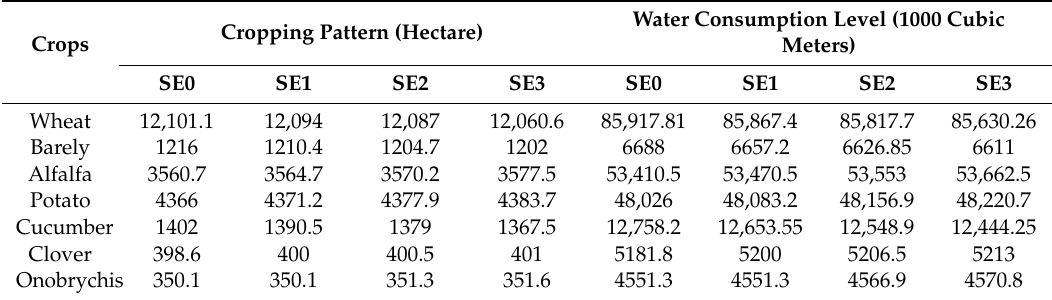
Table A1. The e ff ect of groundwater pricing scenarios on cropping patterns and consumed water level. Crops